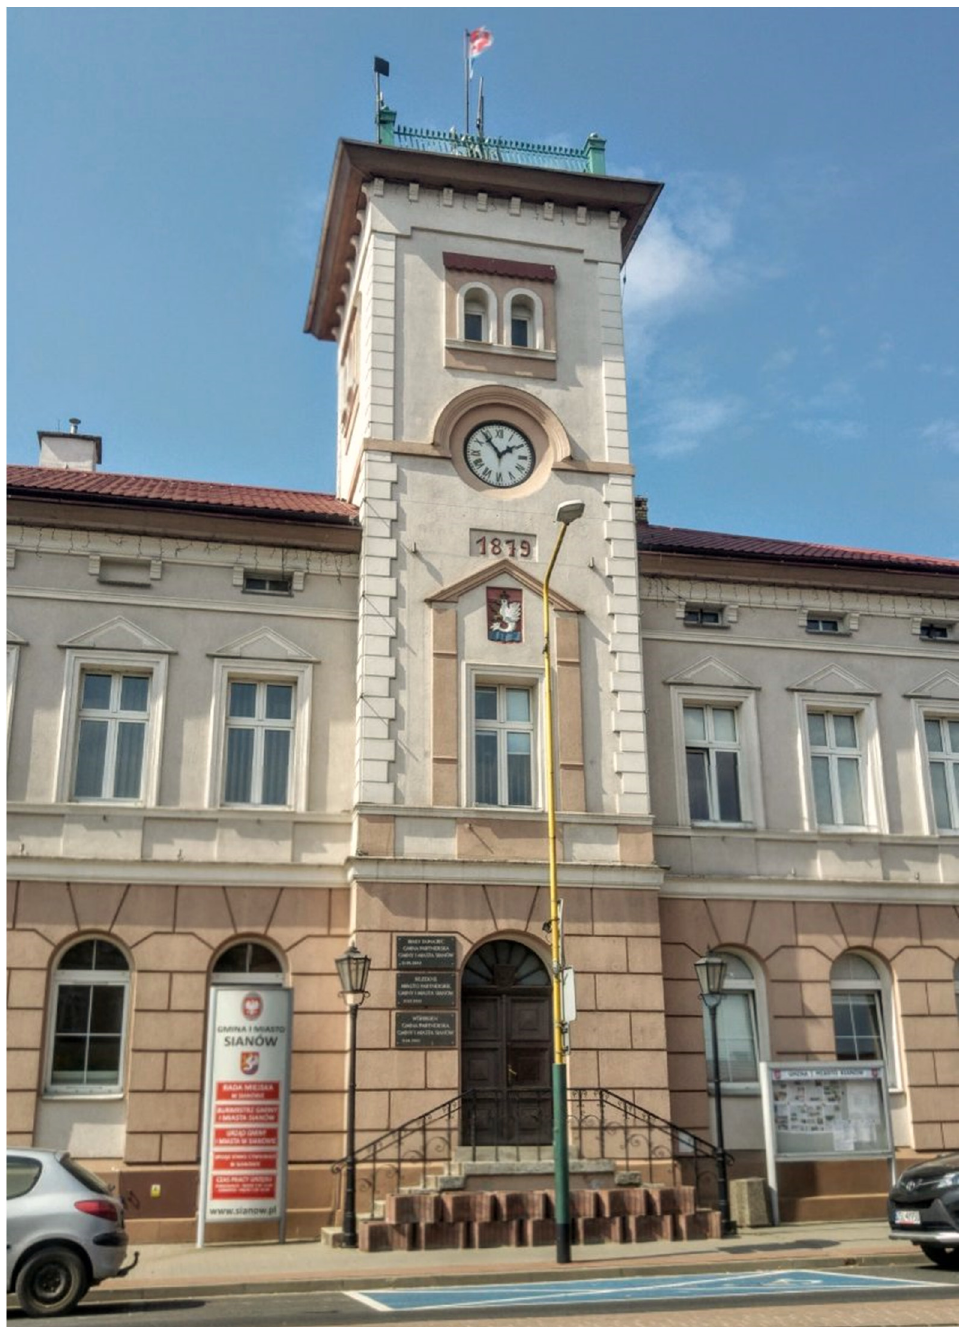
Figure 5. Municipal Office in Sianów, Poland (Photo by Alicja K. Zawadzka, 25 April 2019).